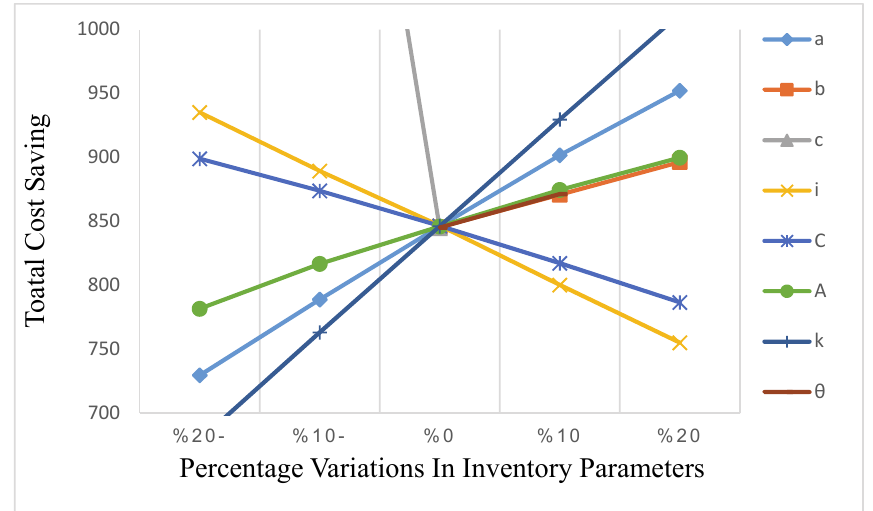
Fig. 10. Variations in total cost saving  